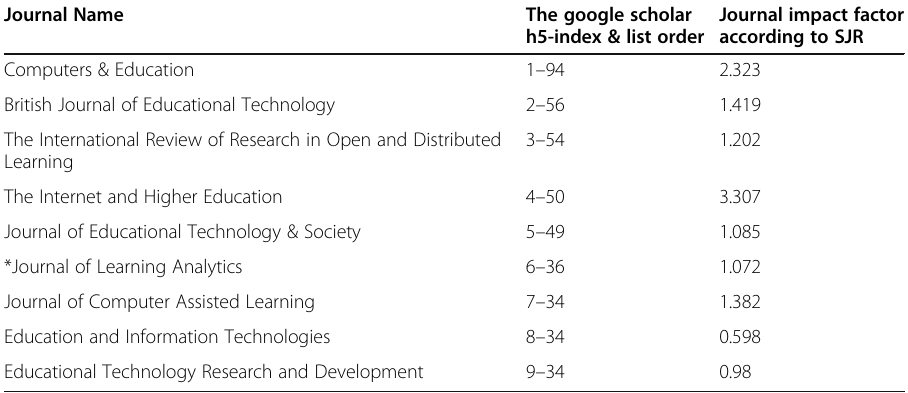
Table 2 The google scholar h5-index and journal impact for selected